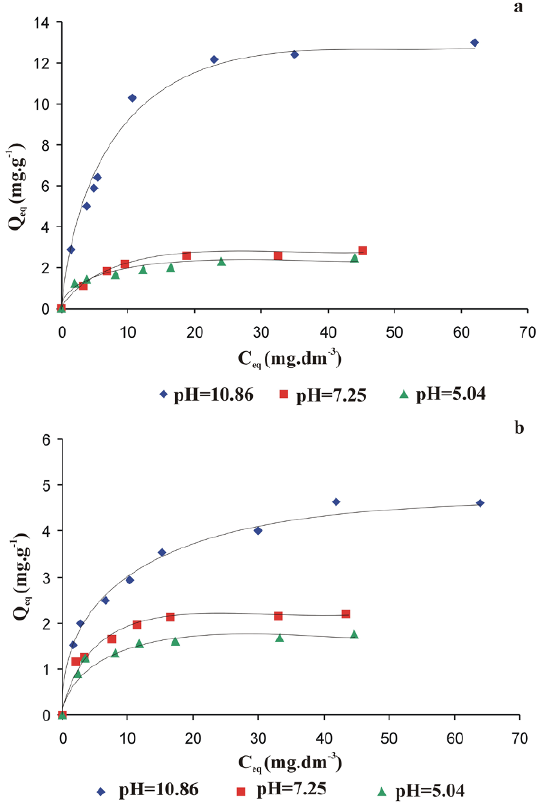
Figure 1. Effect of pH on the adsorption of MB over Co-fresh (a) and Co-Fe-fresh (b) C